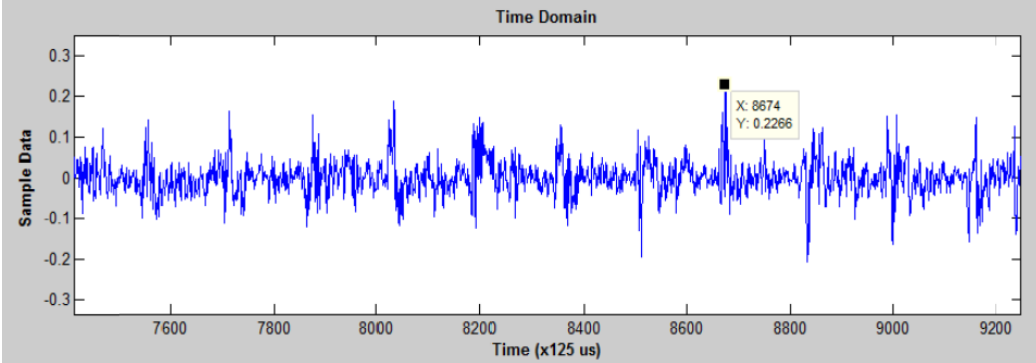
Figure 9. The wave pattern of a corona [35].